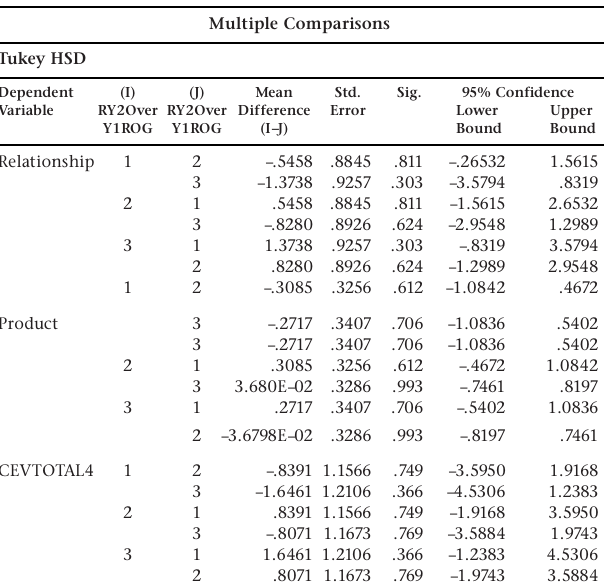
Figure 4: Employee climate and customer value component